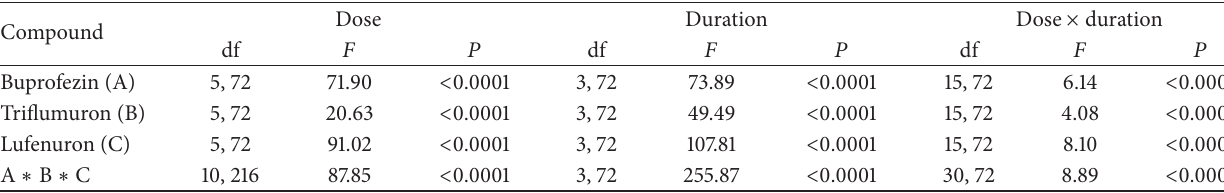
Table 1: ANOVA results on the weight growth change responses of mature earthworms ( A. caliginosa ) exposed to buprofezin, triflumuron, and lufenuron contaminated artificial soil.